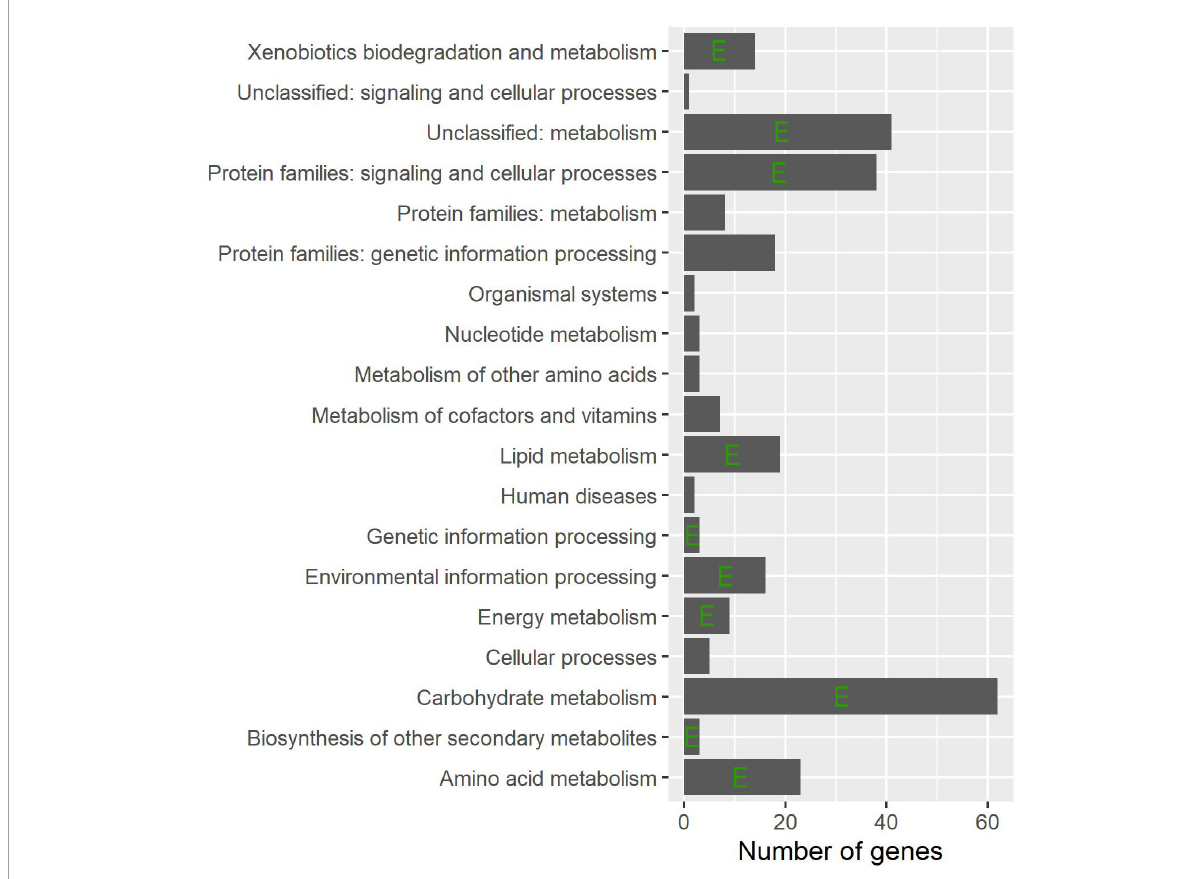
FIGURE3 Distribution of the functional groups for the common DEGs. The horizontal columns indicate the total number of DEGs and the left axis shows their corresponding functional group names. The letter E indicates statistical significance as determined using a hypergeometric test ( P <